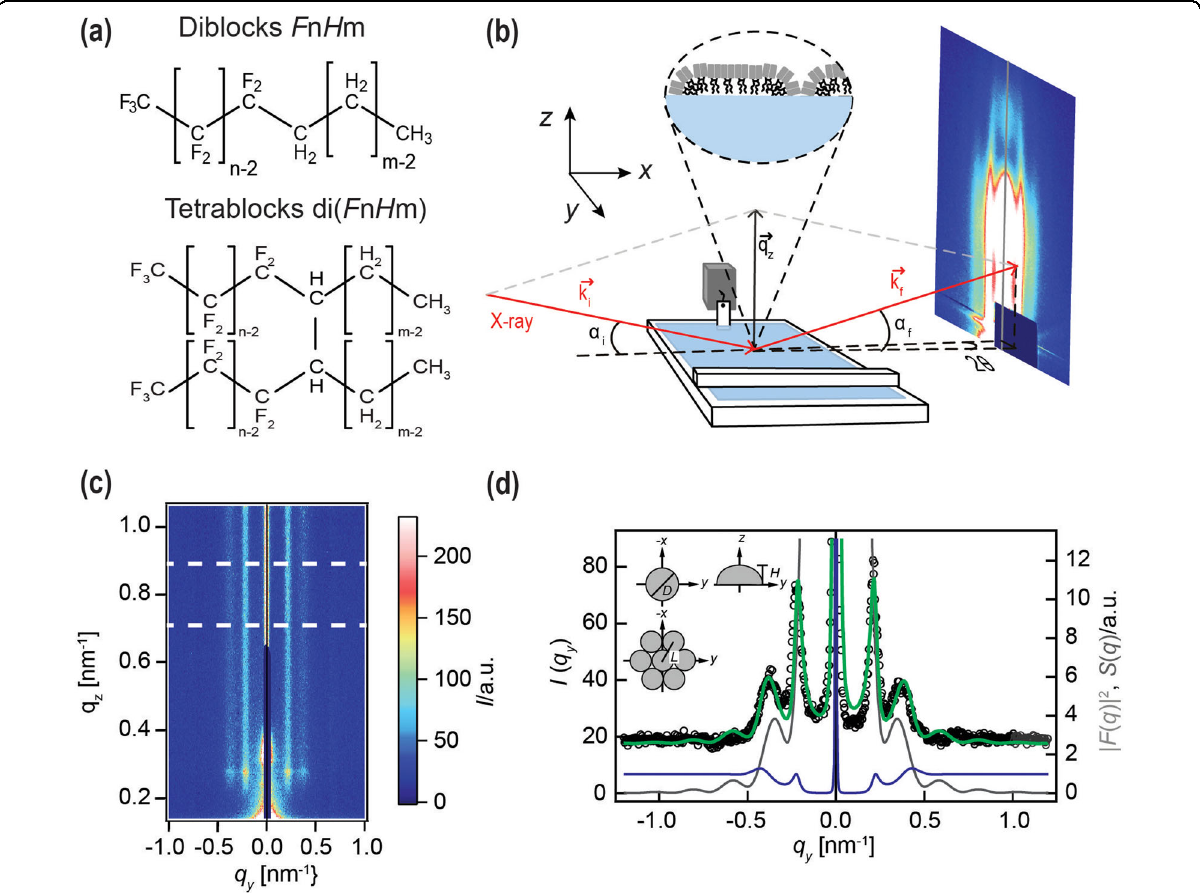
Fig. 2 Shape, size and lateral correlation between mesoscopic domains determined by quantitative grazing incidence small-angle X-ray scattering (GISAXS) analysis at the air/water interface. a Chemical structures of F n H m diblocks and di( F n H m) tetrablocks. b Experimental setup and scattering geometry. c GISAXS signal for the F 10 H 16 monolayer collected using a two-dimensional detector. The black rectangle is the direct beam masked by a beam stop. The signals in the area surrounded by the white broken line were integrated along q z . d Integrated signal intensity plotted against q y (circles). The combination of form factor F ( q y ) (gray) and structure factor S ( q y ) (blue), represented by a gree line, agreed very well with the experimental data. Partially adapted from refs. 52,53